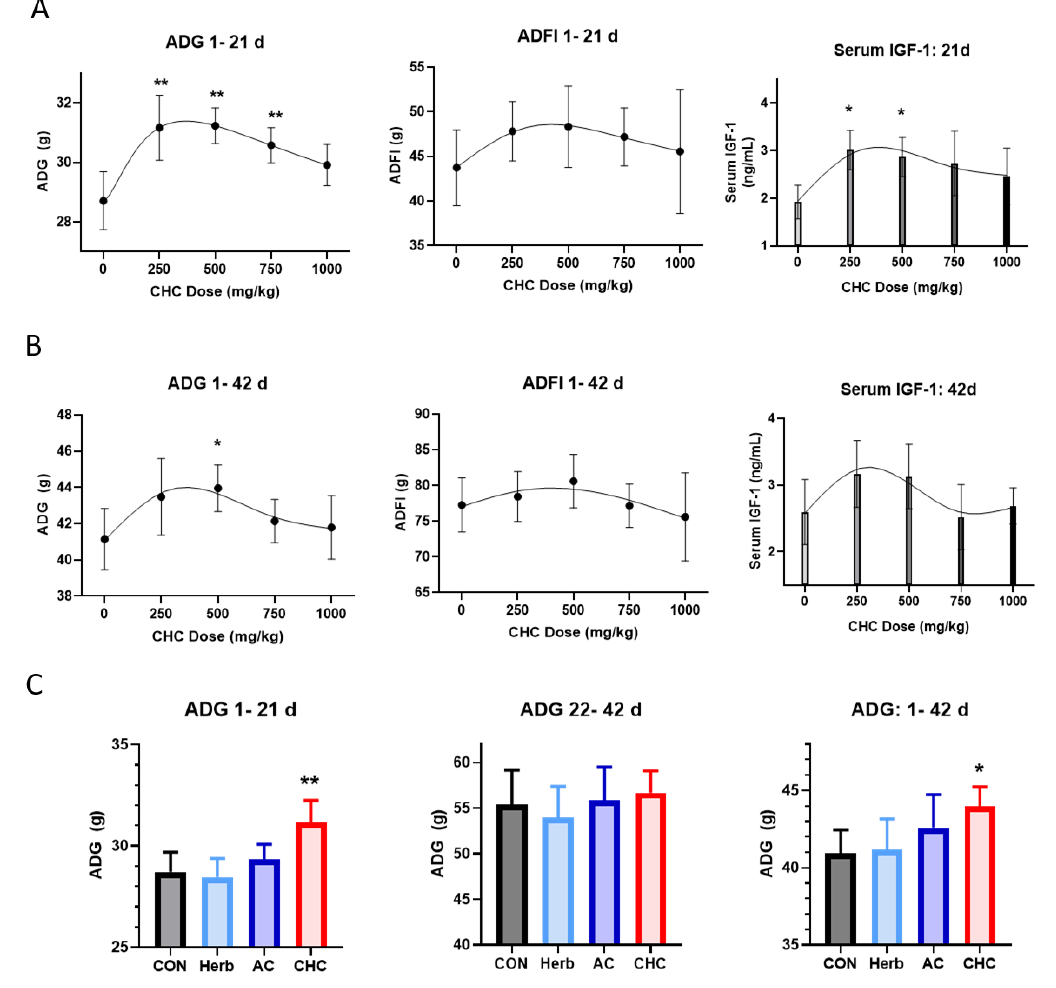
Figure 3. Effects of dietary supplementation on growth performance of broilers. In Experiment 1 ( A , B ), different doses of CHC (0, 250, 500, 750, and 1000 mg/kg) were supplemented in corn- soybean-based diets, which were fed to broilers for 42 days. In Experiment 2 ( C ), broilers were fed CON, Herb (25 mg/kg), AC (225 mg/kg), or CHC (250 mg/kg)-supplemented diets for 42 days. CON was corn-soybean basal die. Herb, herb extracts. AC, activated charcoal. ADG, average daily gain; ADFI, average daily feed intake; IGF-1: insulin-like growth factor 1. t -test was performed to compare differences between CON and the treatment group. Significant differences were labelled as ** ( p < 0.01) or * ( p < 0.05).